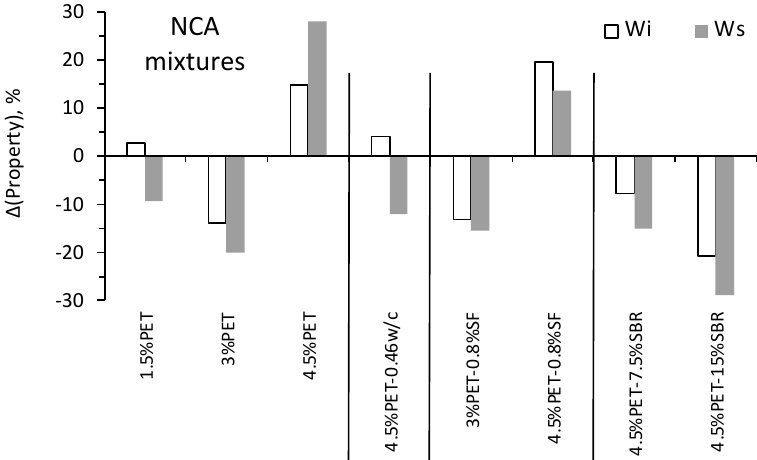
Figure 5. Effect of PET additions on Δ (Sorptivity) for NCA concrete mixtures.